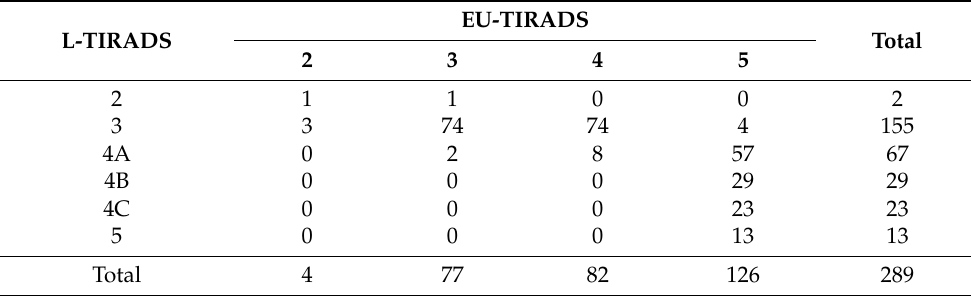
Table 8. Comparison between the L -TIRADS and EU-TIRADS classifications. L-TIRADS